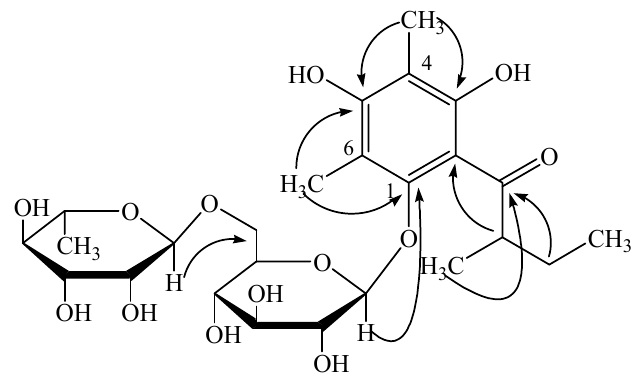
Figure 1. Key HMBC correlations of compound 1 ( 1 H → 13